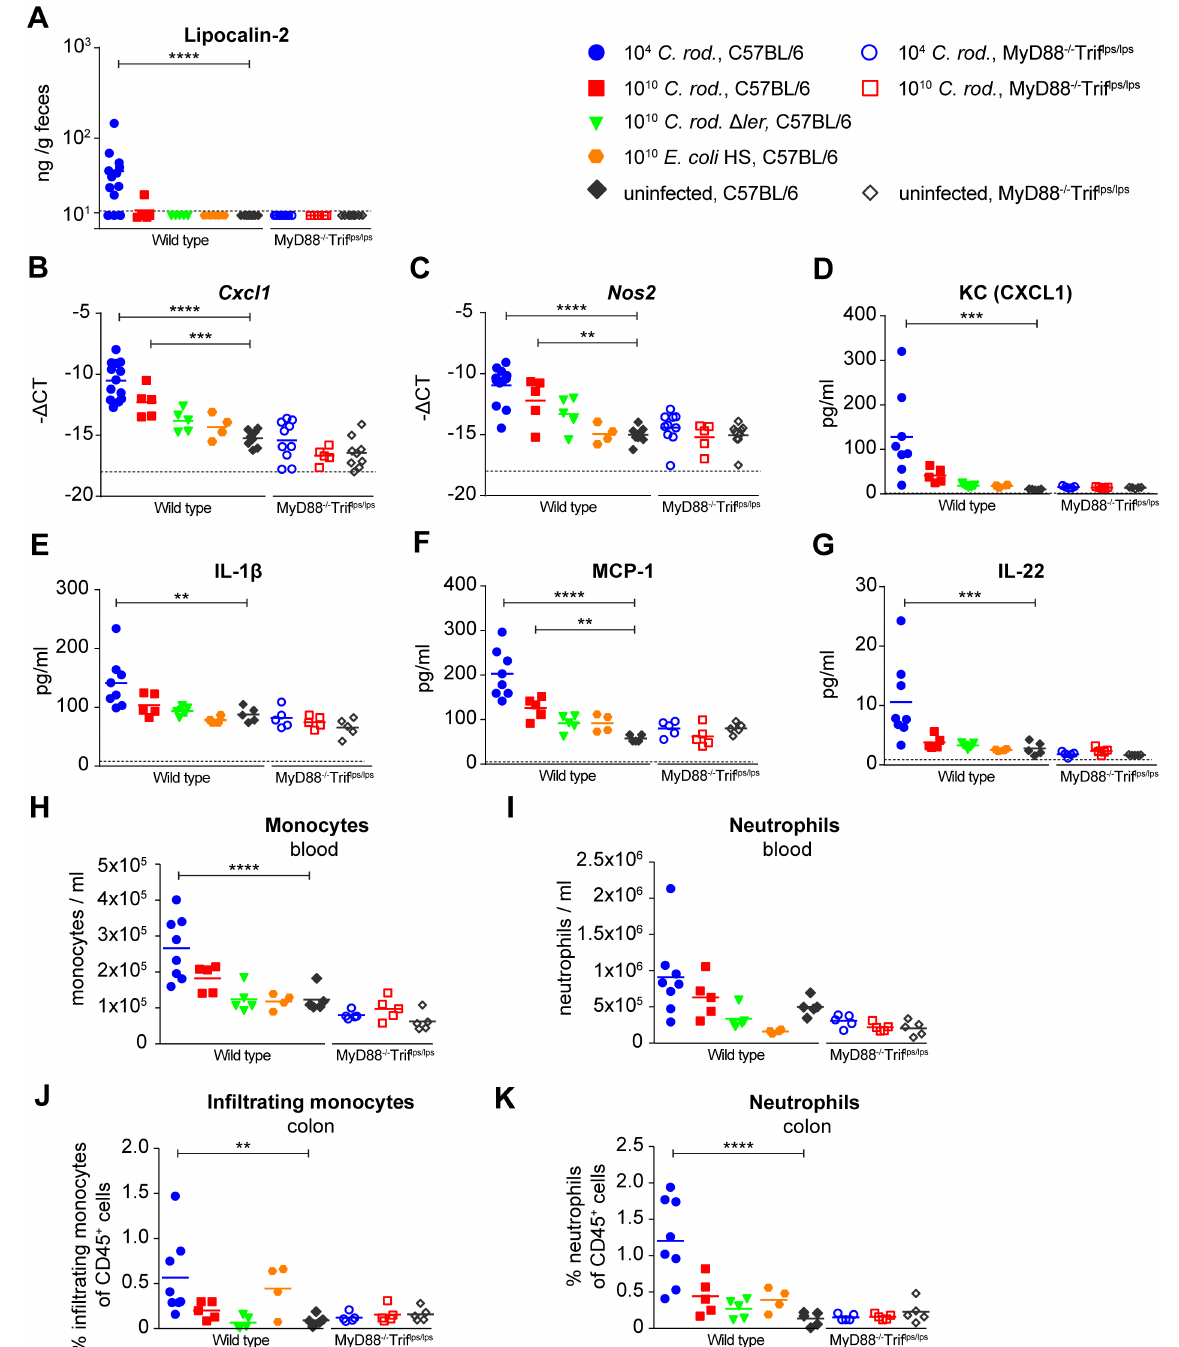
Fig 5. Early C . rodentium -induced innate immune response. ( A ) Lipocalin-2 quantification by ELISA in feces of germ-free mice infected for 18 h with 10 4 CFU C . rodentium (blue circles), 10 10 CFU C . rodentium (red squares), 10 10 CFU C . rodentium Δ ler (green triangles), 10 10 E . coli HS (orangehexagons) or left uninfected(grey diamonds).MyD88 -/- Trif lps/lps germ-free mice were infected for 18 h with 10 4 CFU C . rodentium (open blue circles), 10 10 CFU C . rodentium (open red squares), or left uninfected(open grey diamonds). N = 4–13per group. Data were pooledfrom 3 independent experiments. ( B and C ) Gene expressionlevels of Cxcl1 (B) and Nos2 (C) in the distal colon of infected mice as determinedby qPCR. ( D-G ) Cytokine protein levels in the distal colon of infected mice as determined by Luminextechnology. ( H and I ) Leukocyte analysisby flow cytometry of peripheral blood. Monocyteswere definedas CD45 + , CD11b + , CD115 + population(H). Neutrophils were definedas CD45 + , CD11b + , Ly6G + population.Quantities are expressedas absolute numbers of cells per mL blood.( J and K ) Large intestinalleukocyte analysisby flow cytometry. Infiltrating